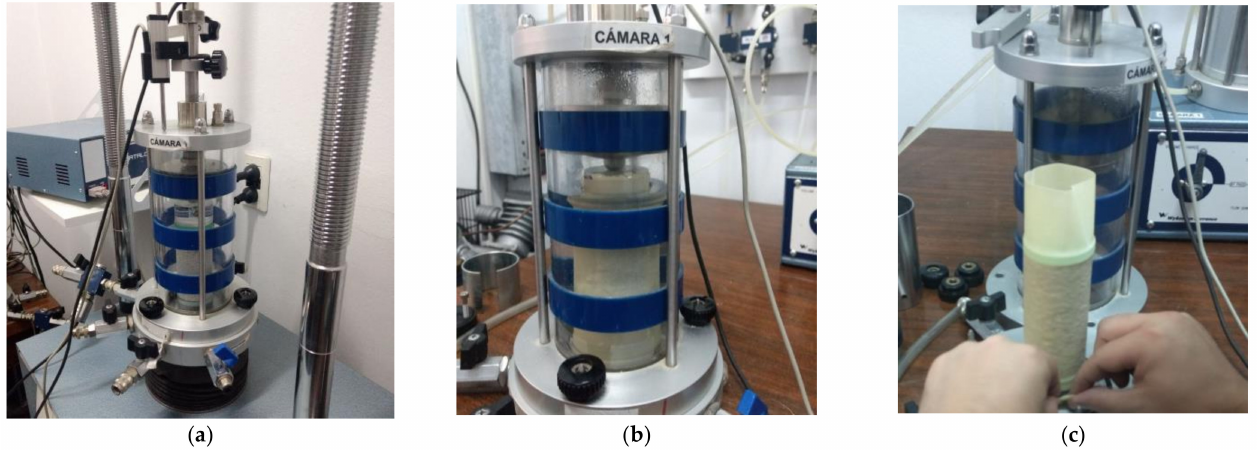
Figure 2. Triaxial compression: ( a ) test setup, ( b ) confinement system, and ( c ) specimen